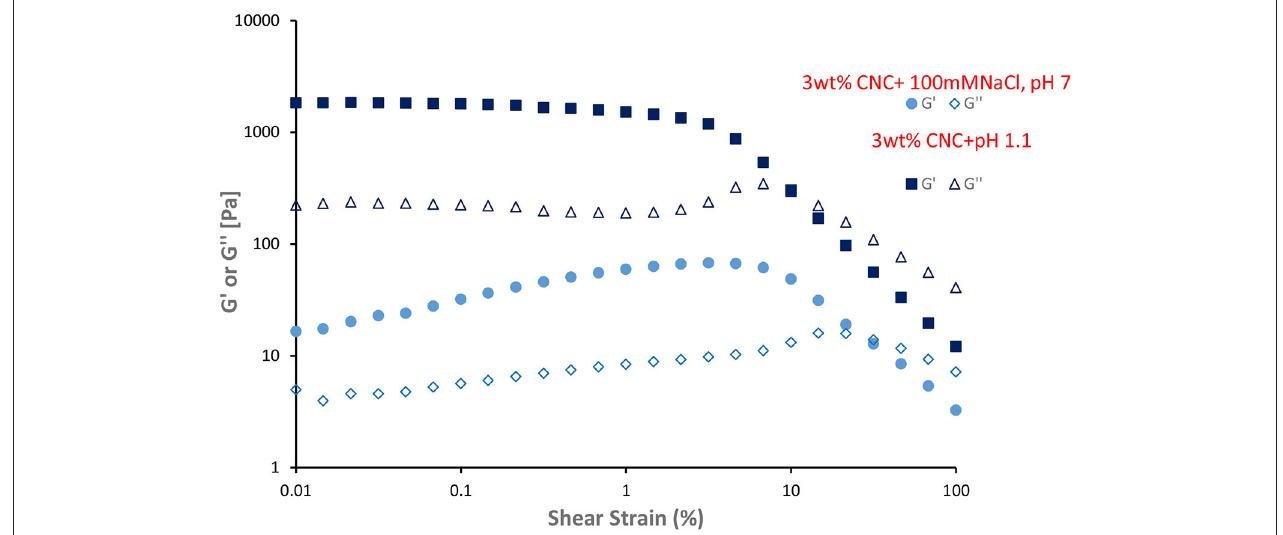
FIGURE 12 | Dynamic strain sweep of gel like emulsions (3 wt% CNC and 100mM NaCl, 3 wt% CNC and pH 1.1) at 25 ◦ C and frequency of 1Hz. Filled symbol indicate elastic moduli (G’) and unfilled symbol indicate loss moduli (G”).